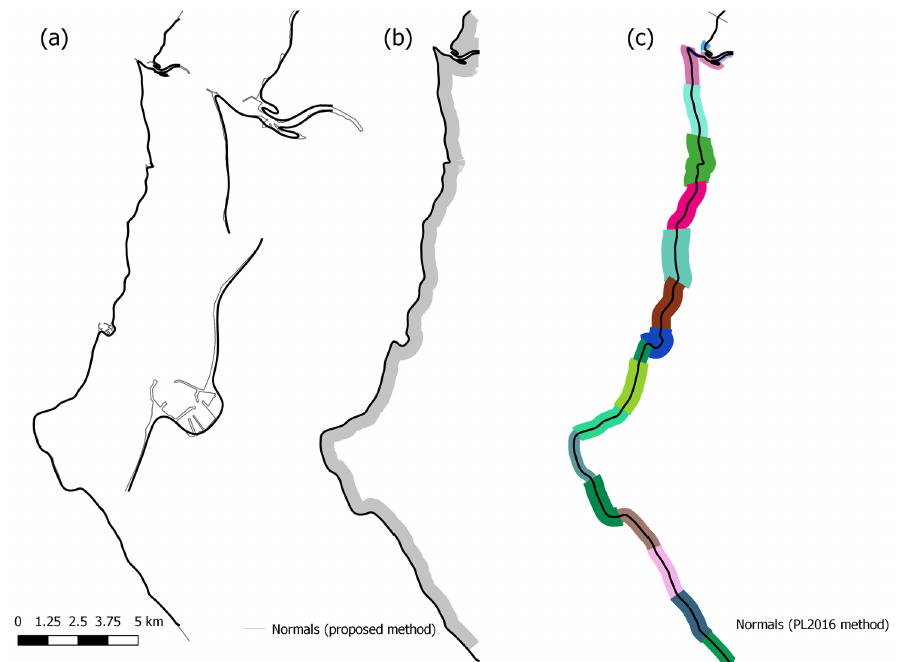
Figure 7. Generalized coastline and coastline normals used for the proposed method and the PL2016 method. (a) Smoothed coastline (solid black) on top of high-water line (solid grey). Close ups around Whitehaven and Workington harbours illustrate the differences between both lines. (b) Coastline normals derived using the proposed methodology. (c) Coastline normals derived using PL2016. The different colours represent the different segments